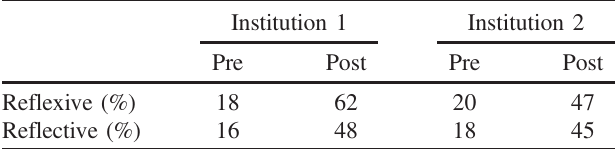
TABLE III. Percentage of responses to Q2 that answered 30 N.